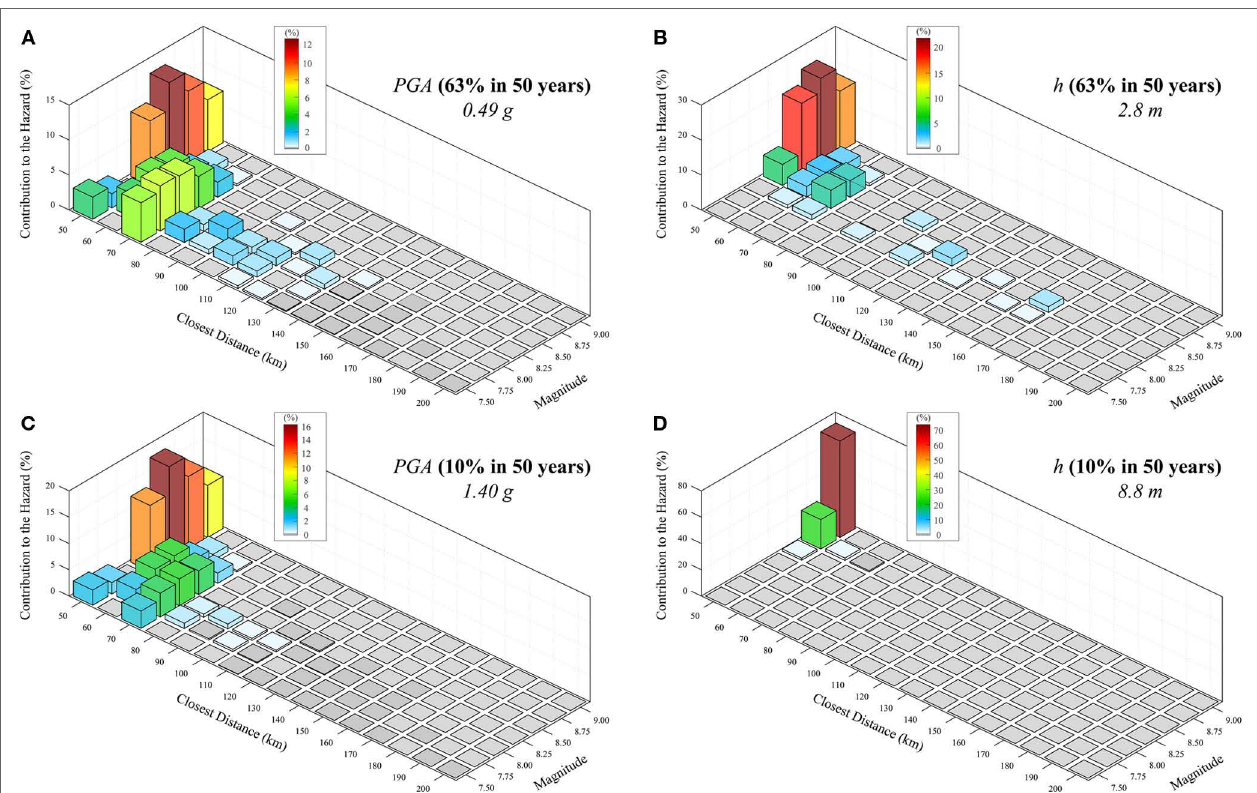
FIGURE 14 | (A) Seismic hazard deaggregation for PGA corresponding to the hazard level of 63% in 50years. (B) Tsunami hazard deaggregation for wave height corresponding to the hazard level of 63% in 50years. (C) Seismic hazard deaggregation for PGA corresponding to the hazard level of 10% in 50years. (D) Tsunami hazard deaggregation for wave height corresponding to the hazard level of 10% in